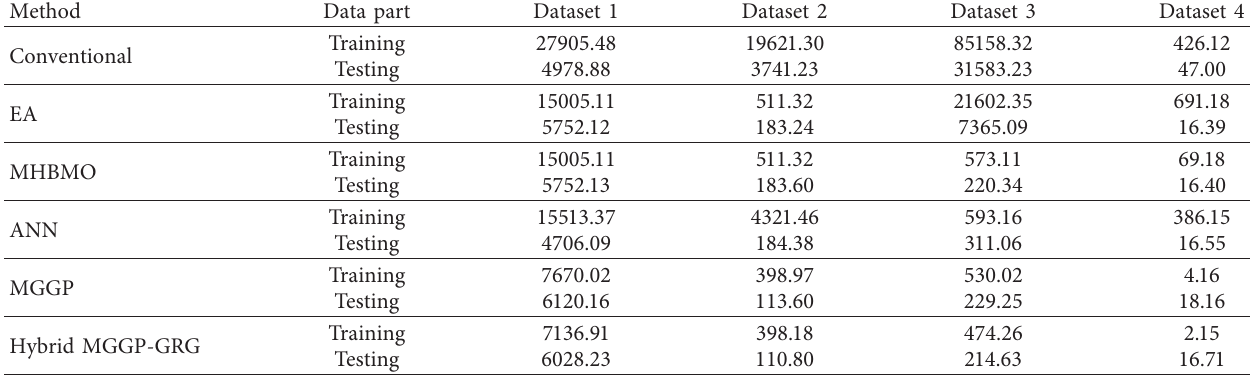
Table 4: Comparing SSE of different methods for developing single-value rating